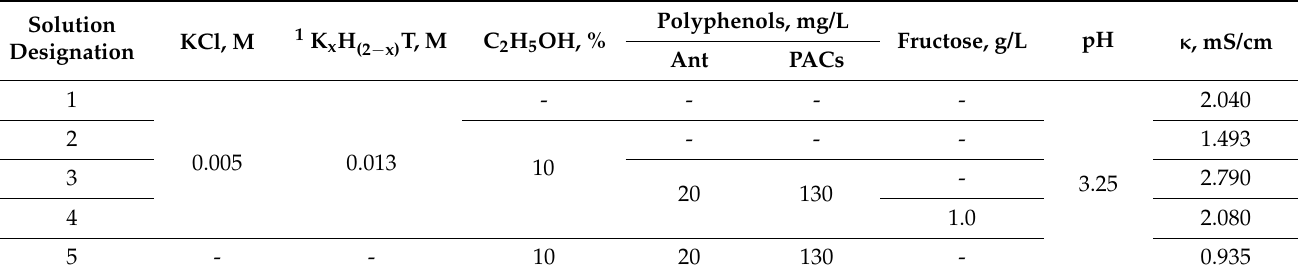
Table 2. Designations and composition of model